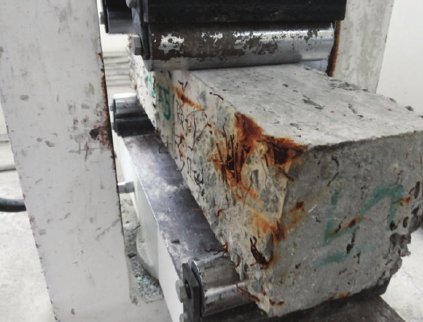
Figure 11: Flexural testing of corroded steel fibre concrete speci- mens.